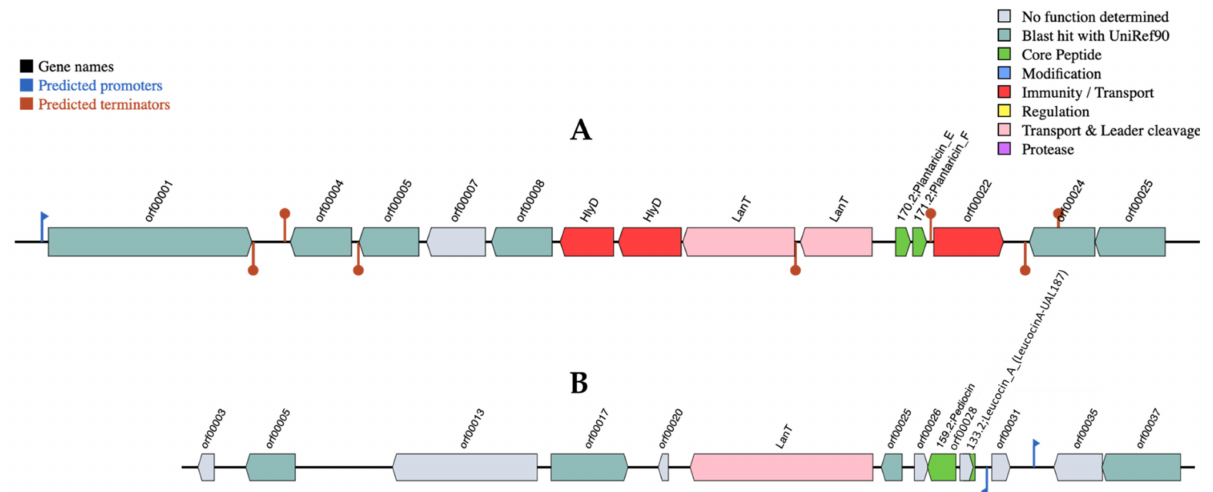
Figure 1. Genetic organization map of the plantaricins ( A ) and pediocin ( B ) gene clusters of the Lpb. plantarum R23